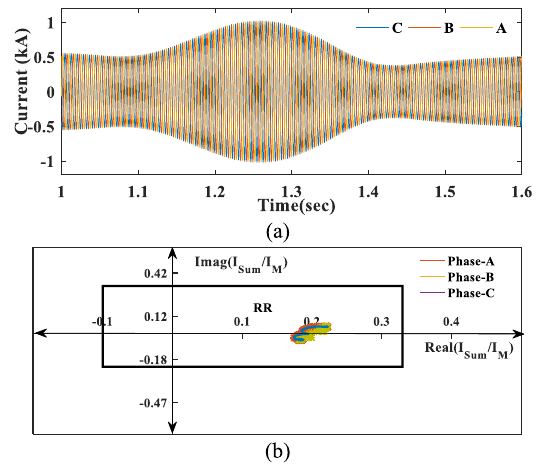
Fig. 11 a CT primary Phase current (kA) during power swing ( b ) CCR during power swing